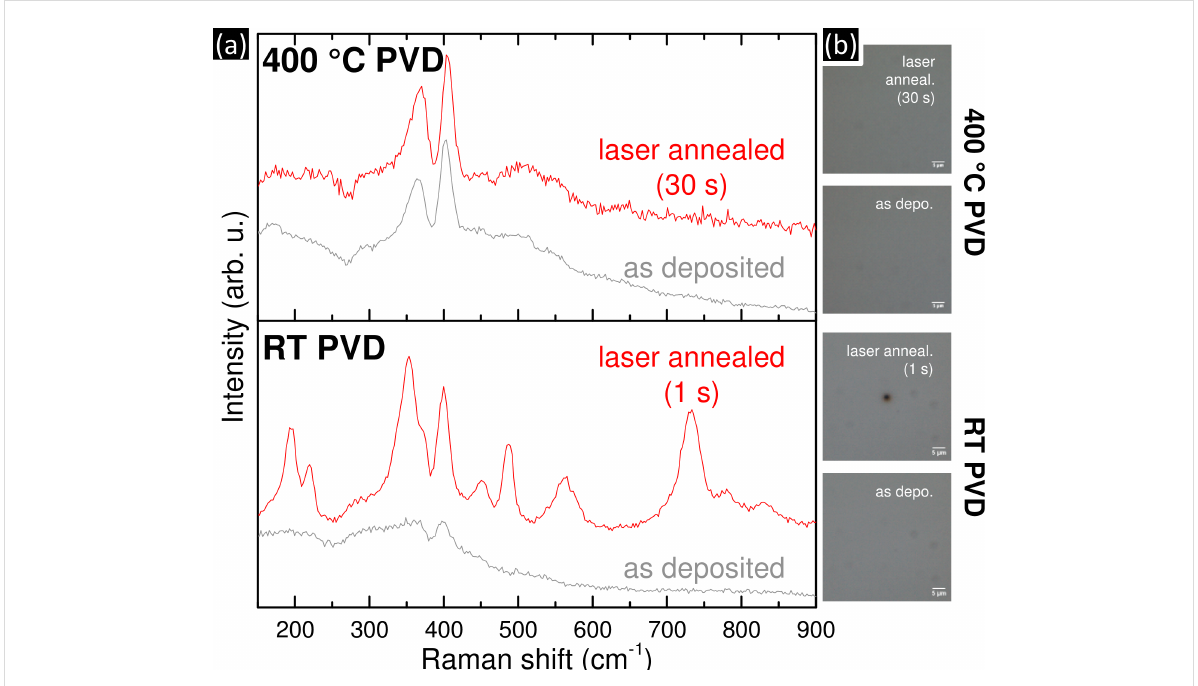
Figure 4: (a) In situ laser annealing Raman spectra of MoS 2 thin films, deposited at RT (bottom panel) and 400 °C (top panel). The Raman spectra of the as deposited films (grey) were taken using a low laser power of 0.75 µW which leaves all tested MoS 2 films unaffected. In situ laser annealing was undertaken by exposure to 3.5 mW laser irradiation for varying times in ambient atmosphere, followed by another low power 0.75 µW measurement after the intense laser anneal (red). (b) Reflected light microscopic images of the film surfaces as deposited and after laser annealing at 3.5 mW, cor- responding to (a).